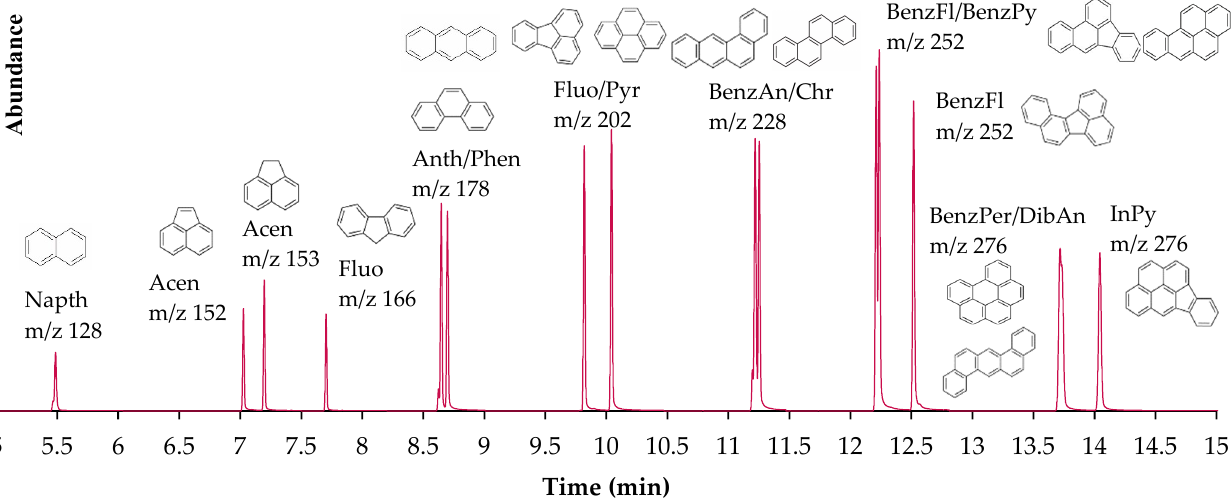
Figure 3. GC–MS chromatogram at 25 µg/mL in DCM for 16 PAHs.